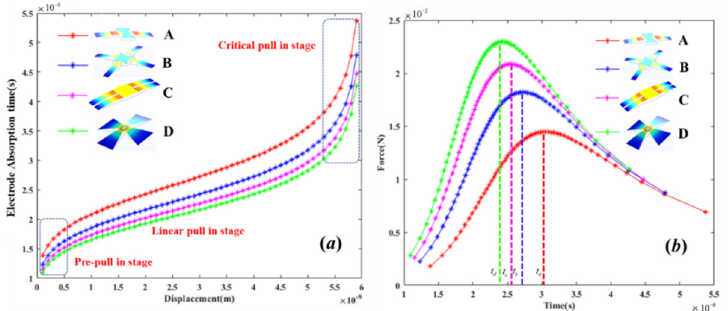
Figure 5. Relationships among absorption time, electrode model, and displacement. ( a ) Relationship between absorption time and displacement for four models. ( b ) Relationship between Force and absorption time for four models.